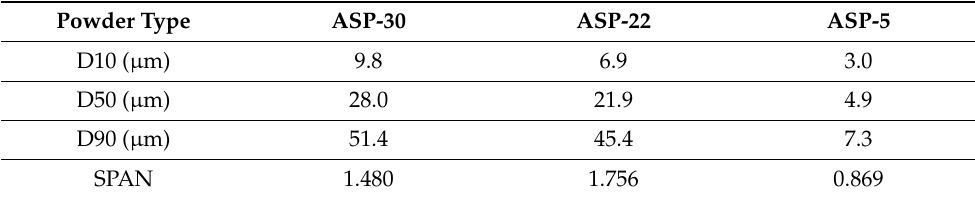
Table 1. Size distribution of the initial